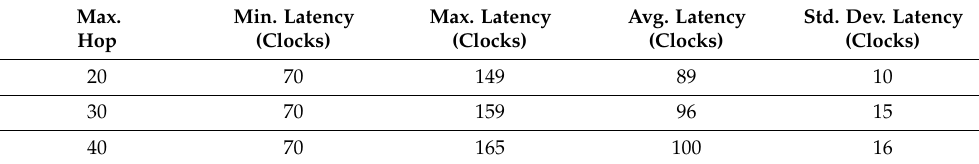
Table 4. Latencies of various depths for UPDATEs.